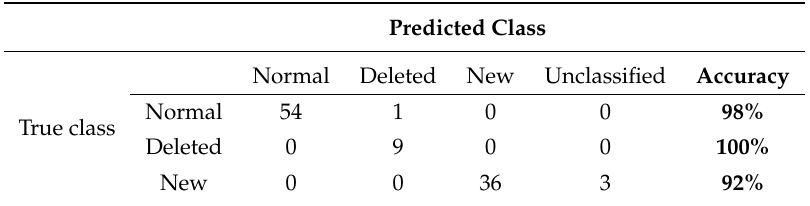
Table 1. Confusion matrix for classification of the map feature changes.